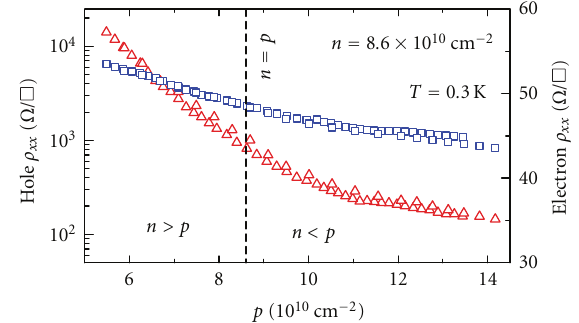
Figure 23: Resistivity of electron (blue squares) and hole (red triangles) layers versus hole density, with electron density fixed ( n = 8 . 6 × 10 10 cm − 2 ) at T = 300 mK. (Device: B138/C4-1-10nm